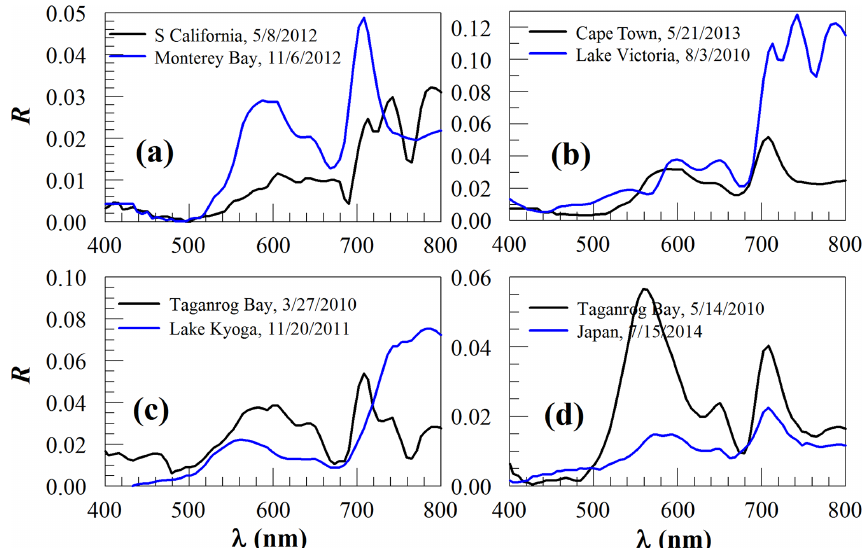
Figure 5. Surface reflectance ( R , dimensionless) of known and unknown algae scums. (a) Blooms off southern California and in Monterey Bay that are thought to be Lingulodinium polyedrum (Cetinic, 2009) and Akashiwo sanguinea (Jessup et al., 2009), respectively. (b) Blooms of unknown types of algae off Cape Town (South Africa) and in Lake Victoria, both likely to be dinoflagellates. Note the different spectra shape of the Lake Victoria bloom as compared with the cyanobacterial bloom in the same lake (Fig. 3b). (c) Blooms of unknown types of algae in Taganrog Bay and Lake Kyoga. (d) Blooms of unknown types of algae in Taganrog Bay (note the difference from Fig. 5c) and in Japanese coastal